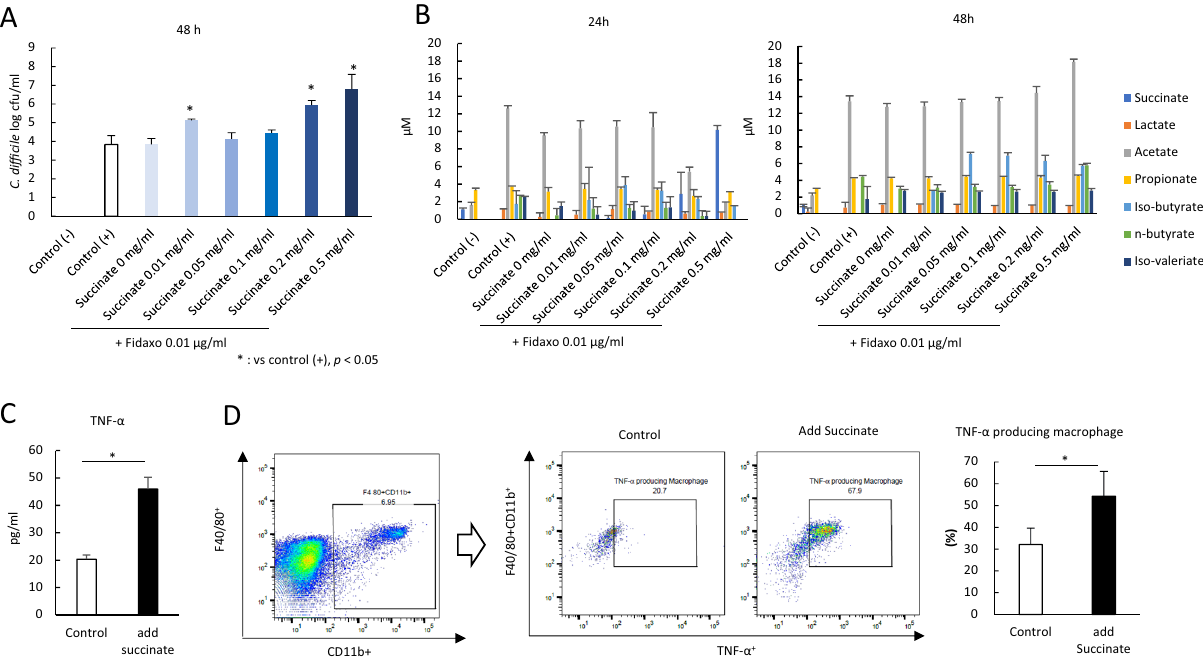
Figure 4. High gut succinate levels induce C. difficile proliferation and cause gut inflammation. ( A ) Assessment of C. difficile in vitro study at 48 h. 1: control group without C. difficile inoculation (Control (−)), 2: control group with C. difficile inoculation (Control (+)), 2–8: treatment group with succinate 0–0.5 mg/ml under fidaxomicin 0.01 μg/ml. The testing detectable level is above 2.0 (log amount) per ml of medium, data shown as mean ± SD (n = 5 per group). ( B ) Concentration of organic acids in the medium. Samples were taken at 24 h (left) and 48 h (right). All values are mean ± SD (n = 5). ( C ) Tumor necrosis factor-α (TNF-α) protein concentration in mice colon tissue detected at day 5. All values are mean ± SD (n = 5–10). ( D ) Representative flow cytometry plots of identified macrophages (F40/80 + /CD11b + ), and tumor necrosis factor-α (TNF-α) producing macrophage (F40/80 + /CD11b + /TNF-α + ) expression among lymphocytes in the colonic lamina propria (cLP) in the control group (Control), and the other group with succinate administration for 4 days (Add succinate). Percentage of TNF-α secreting macrophages in macrophages